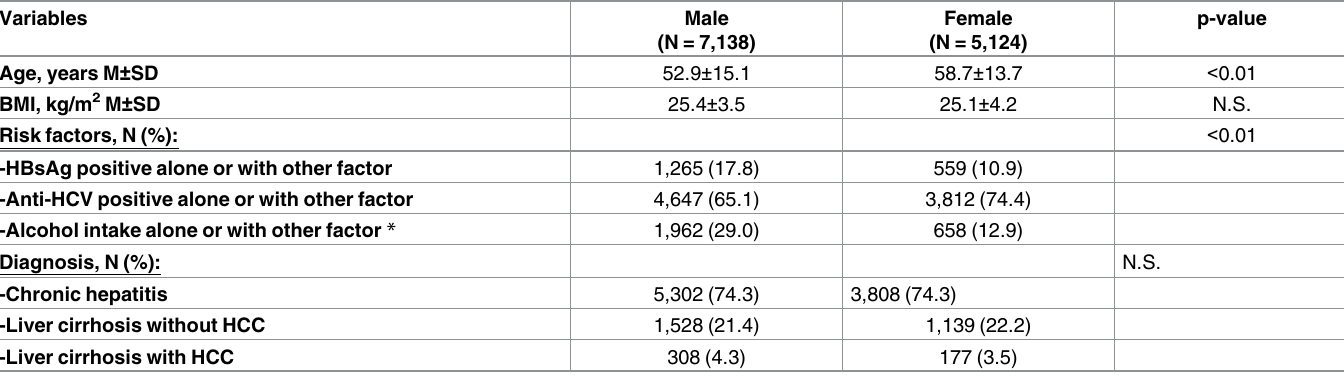
Table 1. Baseline characteristics of 12,262 enrolled subjects by sex.